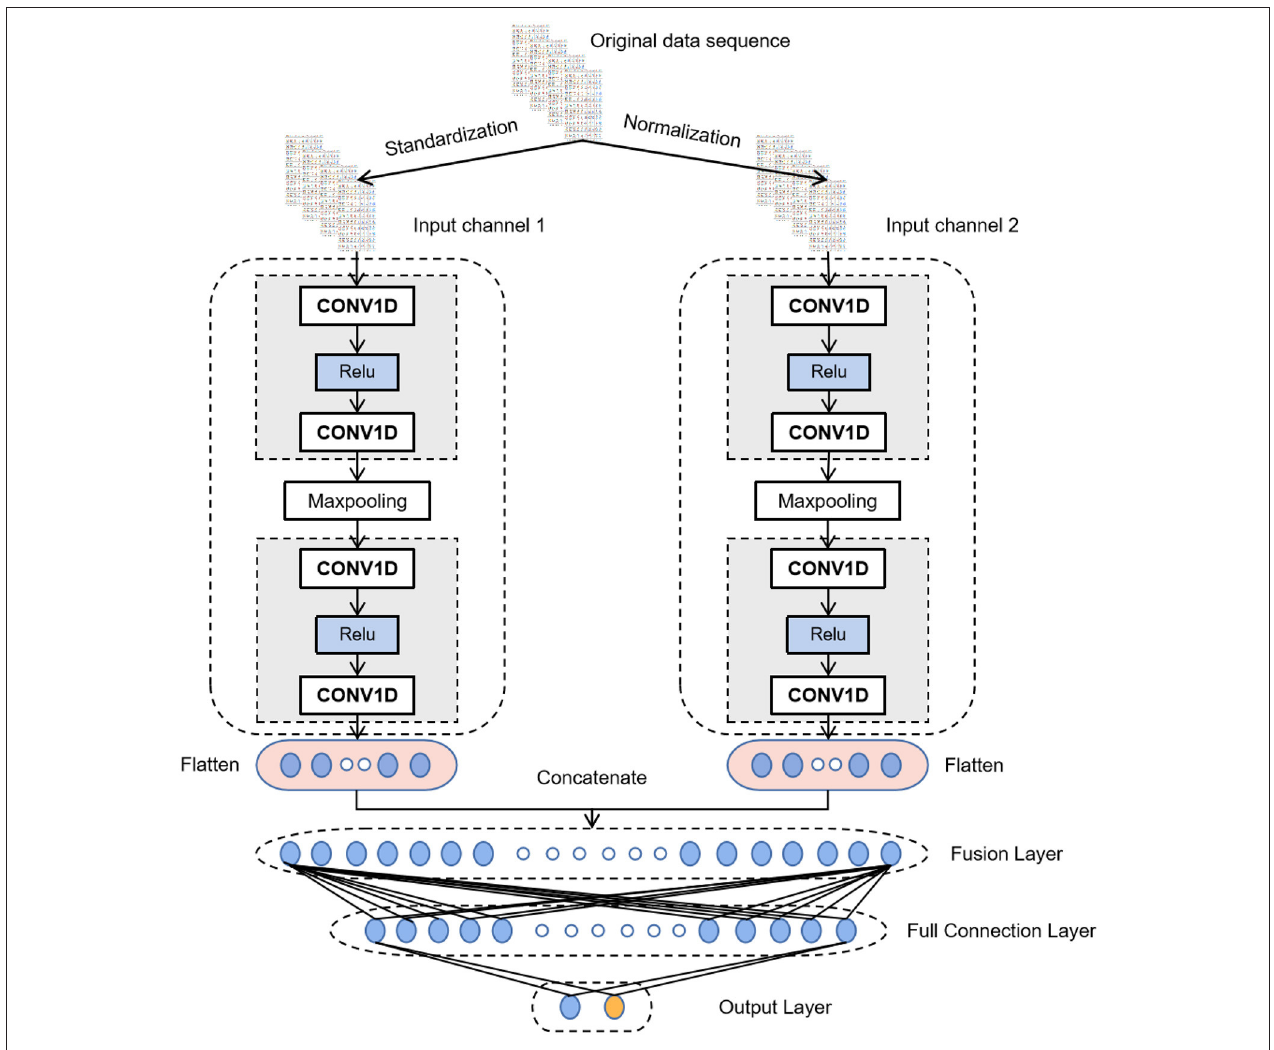
FIGURE 3 | Network structure of MI-CNN.